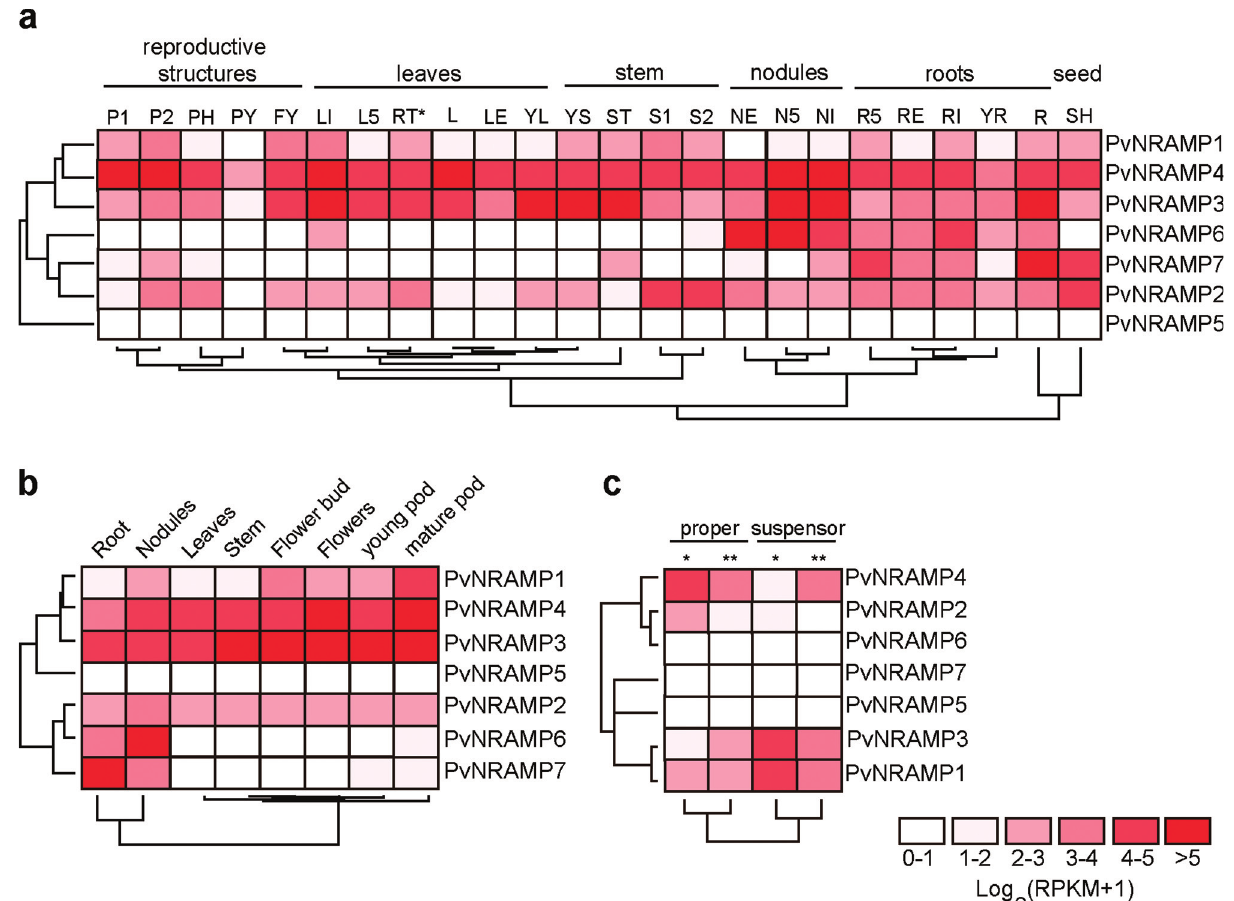
Figure 6 - Expression levels of P. vulgaris NRAMP genes. Heatmaps showing the hierarchical clustering of NRAMP family genes grouped according to the expression patterns of RNA-Seq data collected from different tissues during the development of P. vulgaris . Gradient color ranging from white to bright red corresponds to expression values calculated as Log2(RPKM + 1), as described by the legend at the bottom. (a) RNA-Seq based on gene expres- sion atlas of the common bean (O’Rourke et al. , 2014). Expression P1: pods with 10–11 cm; P2: pods with 12–13 cm; PH: pods with 9 cm; PY: young pod;FY:youngflower;LI:leaftissueafter21daysfrominoculationofanineffectiverhizobium,L5:leaftissue5daysaftertheinoculationofaneffective rhizobium; RT: root tips; SH: heart stage seeds; L: leaf tissue of non-inoculated plant; LE: leaf tissue 21 days after the inoculation of an effective rhizobium;YL:youngleaf;YS:youngstem;ST:shootapicalmeristem;S1:seedswith6–7mm;S2:seedswith8–10mm;NE:effectivelyfixingnodules; N5: pre-fixing nodules collected at 5 days after inoculation; NI: ineffective nodules; R5: root system separated from pre-fixing nodules; RE: root sepa- rated from effectively fixing nodules; RI: root separated from ineffectively fixing nodules; YR: radicle; R: roots without rhizobium inoculation; RT: root tips; SH: heart stage seeds. (b) 10-day-old root and stem tissues and pool of leaves at different developmental stages (Schmutz et al. , 2014). (c) Embryo dissected by laser at heart stage (GSE57535), the expression data in the proper and suspensor embryo tissues are shown. (*) and (**) asterisks correspond to first and second biological